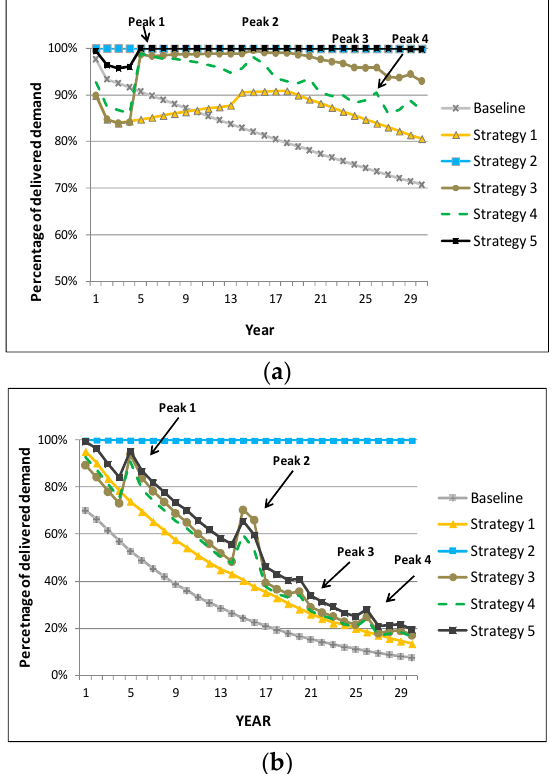
Figure 8. Coverage of demand with supply over the planning horizon for the ( a ) slow growth and ( b ) very fast growth scenarios in Puerto Ayora.